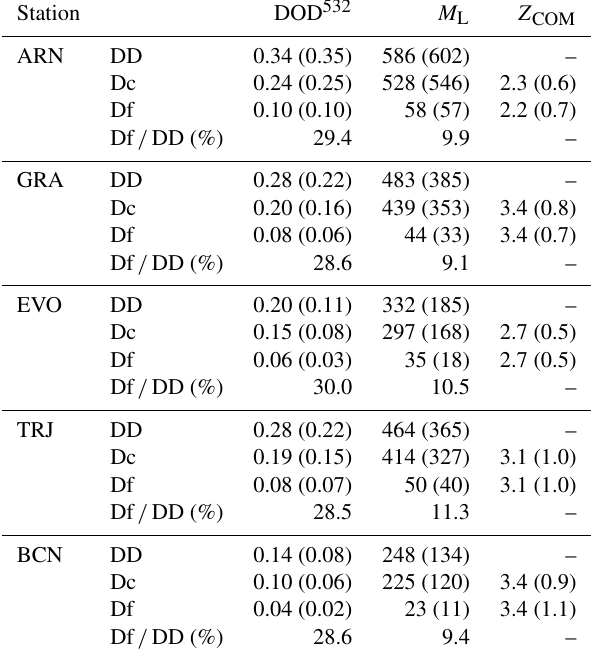
Table 2. Mean values of the dust optical depth at 532nm (DOD 532 ) and mass loading ( M L , in mgm − 2 ) for fine dust (Df), coarse dust (Dc), and total dust (DD), and the Df-to-total dust ratio (Df / DD), referring to the DOD 532 (ftr_ DOD ) and M L (ftr_ M L ) for the whole dust event over the five Iberian lidar stations (ARN, GRA, EVO, TRJ, and BCN). The centre-of-mass height ( Z COM ) is also included for both the fine and coarse dust components. The standard devia- tion values are in